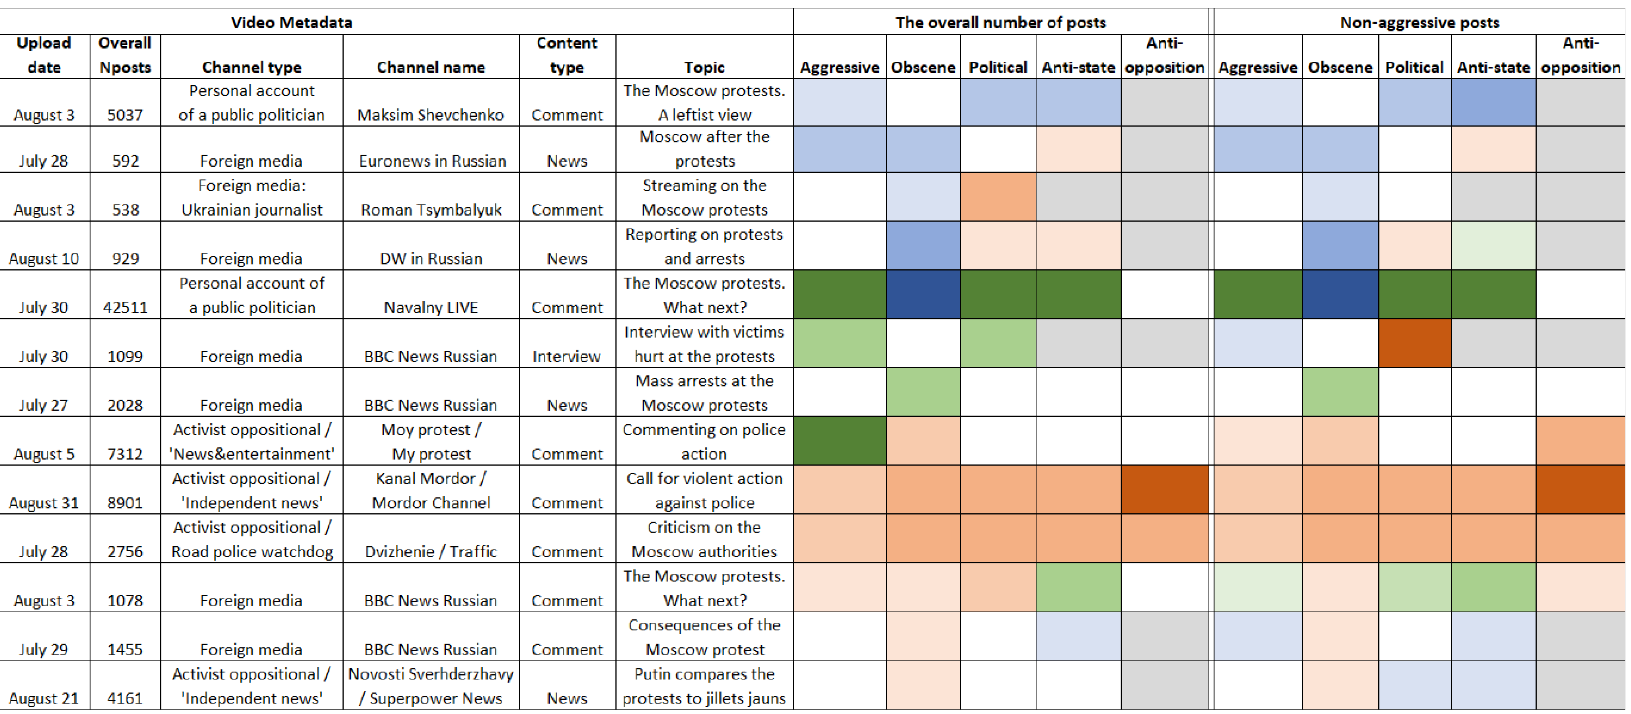
Figure 2. The mixed effects of communicative aggression on the dynamics of the overall number of posts and the number of neutral posts (two-hour increment), accompanied by video metadata. Note: Blue—direct effect; green—reciprocal (both direct and reverse) effect; orange—reverse effect; grey—data too scarce for the